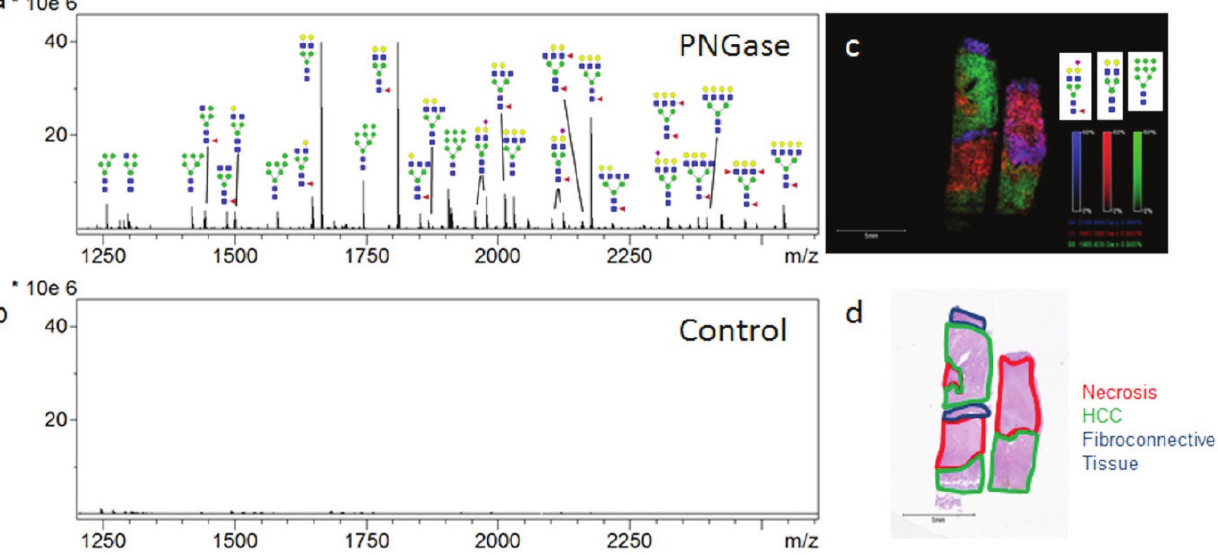
Figure 1. PNGaseF Releases N -linked Glycans from HCC Tissue in a Spatially Defined Manner. A HCC tissue slide (Biochain) containing two serial slices of HCC tissue was analyzed by N -glycan MALDI-IMS ( a ); One section was shielded from enzyme application to serve as a negative control ( b ); Three representative ions were selected in FlexImaging and displayed as an overlay image ( c ). Hex5dHex1HexNAc4NeuAc ( m / z = 2100.759, blue), Hex5HexNAc4 ( m / z = 1663.582, red) and Hex9HexNAc2 ( m / z = 1905.612, green) each display unique localization within the tissue slice ( c ); As highlighted in the H & E stain of the slide ( d ), indicated regions were identified to be fibroconnective tissue (blue), necrotic tissue (red), and HCC tissue (green). Tri- and Tetra-antennary compositions are shown with representative glycan structures. Glycan structures with single fucoses are shown as being attached to the core N -acetylglucosamine for consistency. All of these representations need to be confirmed by other